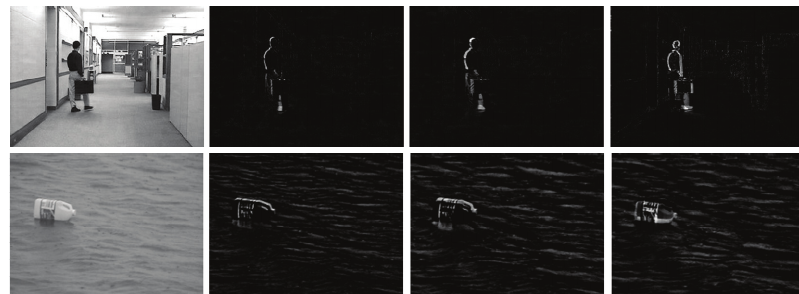
Figure 3. Compare with three kinds of frame difference methods. The first column is the monitor’s image sequence of the static background. The second column is the boat’s image sequence of dynamic background. From left to right: original video, results of two frames’ difference, three frames’ difference and the proposed